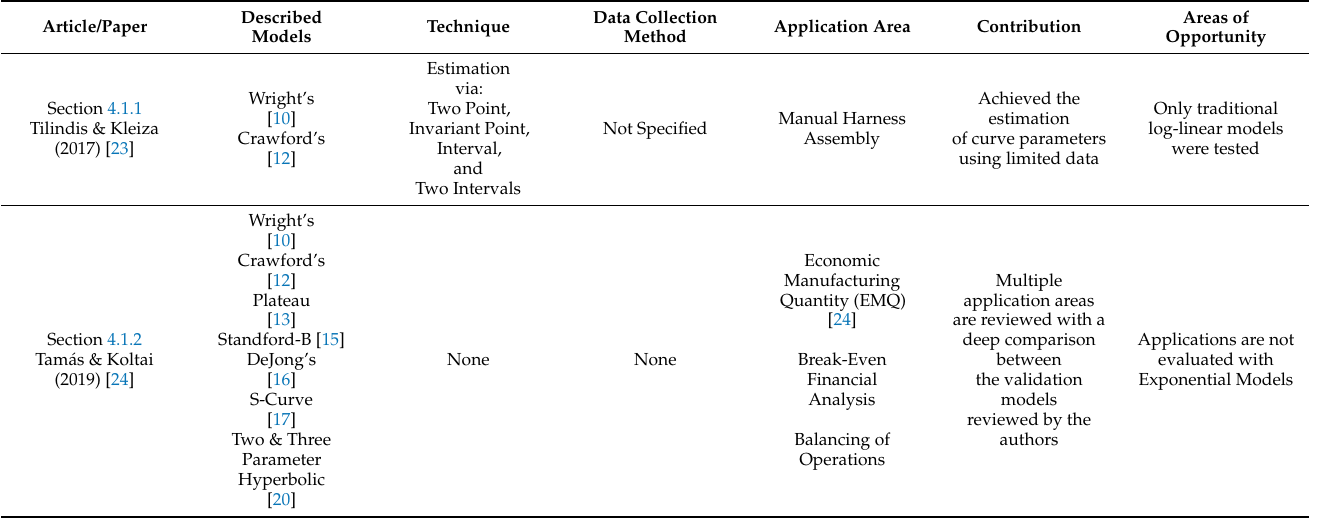
Table 4. Comparison of Domain 1—Reviewed journal articles and conference papers for learning curve